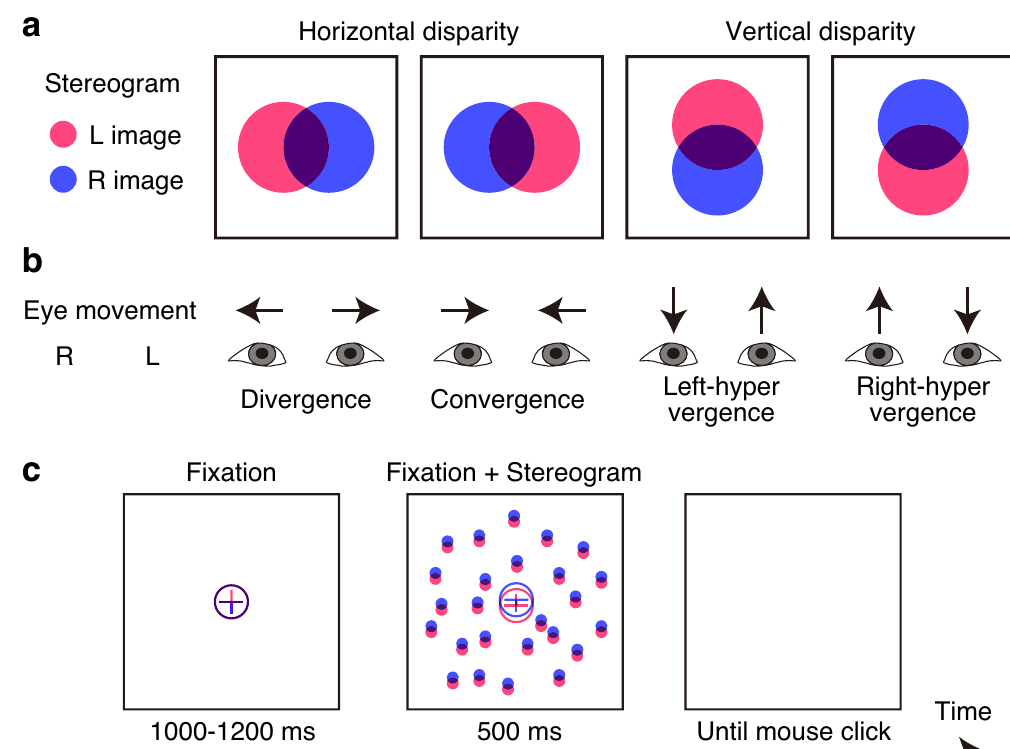
Figure 1. Schematic illustration of the visual stimuli, eye movement, and trial sequence. ( a ) Four stimulus conditions. Red and blue disks indicate the elements presented to the left and right eyes, respectively. ( b ) The corresponding four types of disparity-induced vergence. ( c ) An example of the trial sequence (the right- hyper vertical disparity condition). After a presentation of the fixation pattern, a random-dot stereogram was presented for 500 ms. The subjects’ primary task was to keep their eyes on the fixation